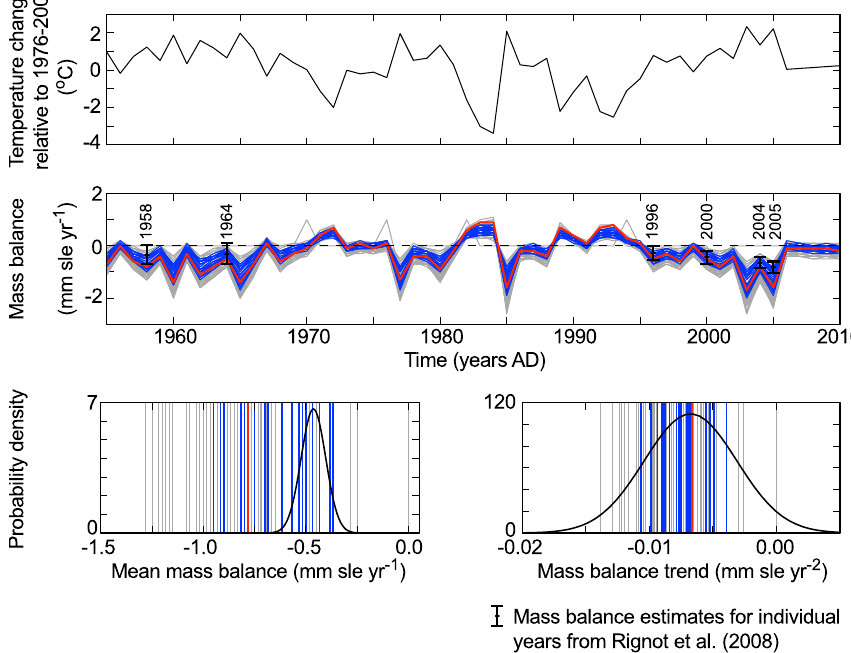
Fig. 9. Comparison of simulated and observed ice sheet mass balance over the last half-century. Color coding for model results follows that in Fig. 3. The temperature data are from Vinther et al. (2006). The mass balance estimates (Rignot et al., 2008) are shown with 2 σ uncertainties for clarity. As expected, simulated mass balance is closely tied to temperature; low temperatures are associated with a more positive mass balance (top and middle panels). The black curves in the bottom two panels are based on Monte Carlo sampling from the individual mass balance estimates, assuming that these estimates are independent of one another. The vertical lines in these panels are based on sampling the model curves for only those years in which mass balance observations are available, allowing for a clean comparison between the model and the data. Lines that fall close to the centers of the black curves indicate runs that agree well with the mass balance data. Because many runs that pass the modern volume test (Fig. 3) do not agree well with the mass balance data, these results suggest that recent mass balance estimates provide a useful additional constraint for ice sheet model